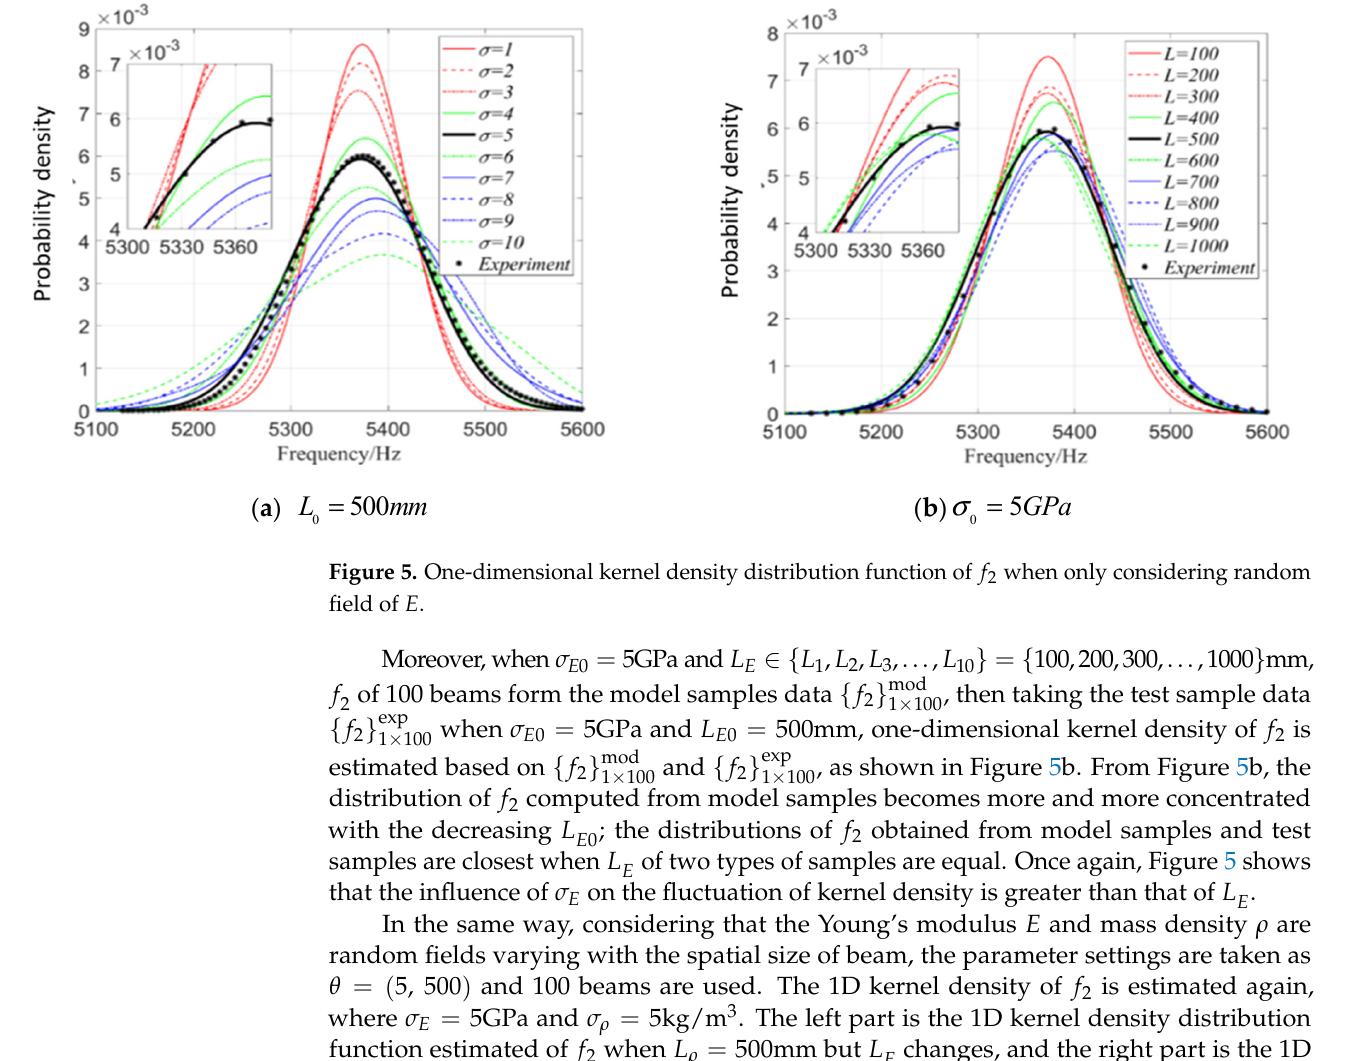
Figure 5. One-dimensional kernel density distribution function of f 2 when only considering random field of E .